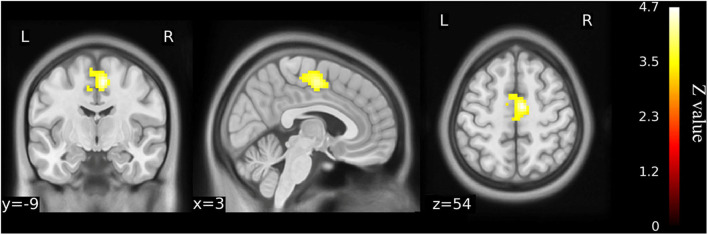
Functional connectivity shows the difference between older KOA patients and healthy matched controls (n = 23) on the basis of left precuneus gyrus as the ROI for analysis (voxel-wise p < 0.001 and cluster-wise p < 0.025 for each tail, corrected by GRF). Compared with controls, left precuneus gyrus has increased functional connectivity with right supplementary motor area (SMA) in the older KOA patients, but it reverts to no significant difference in the postoperative patients. The color bars range from zero to vmax, which denotes the maximum z-value. KOA, knee osteoarthritis.